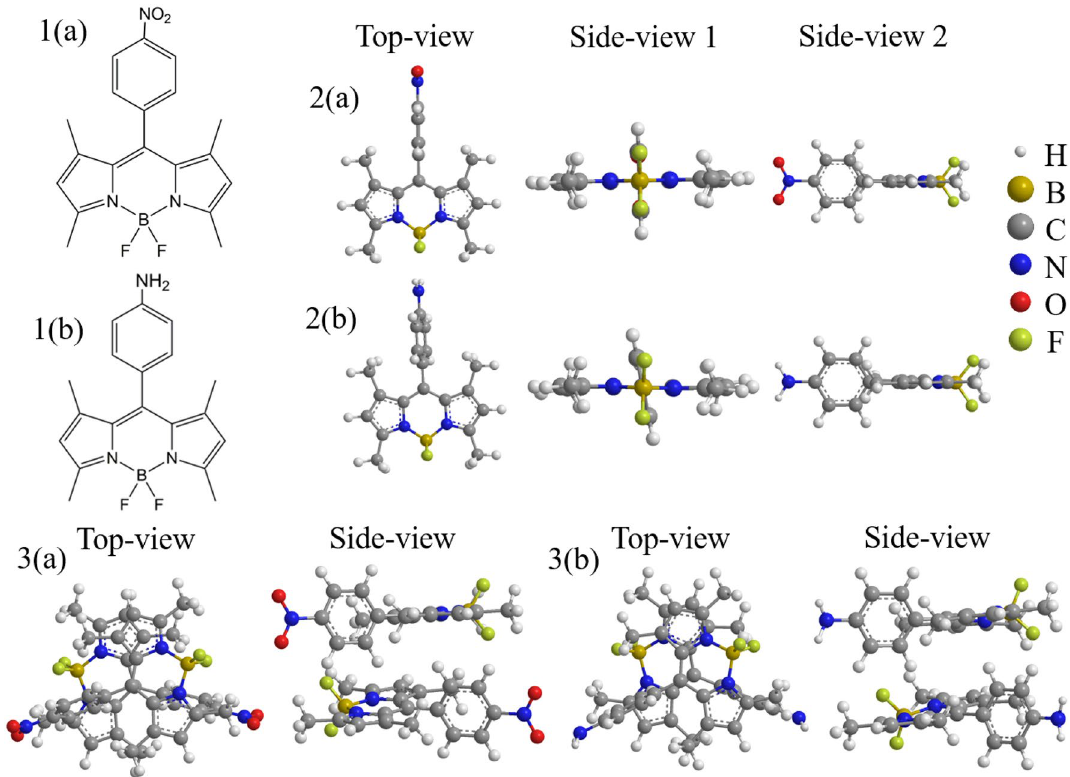
Figure 1. Optimized structures of TMBODIPY derivatives ( a ) and ( b ) monomers and their π -stacking dimers including the solvent effect of